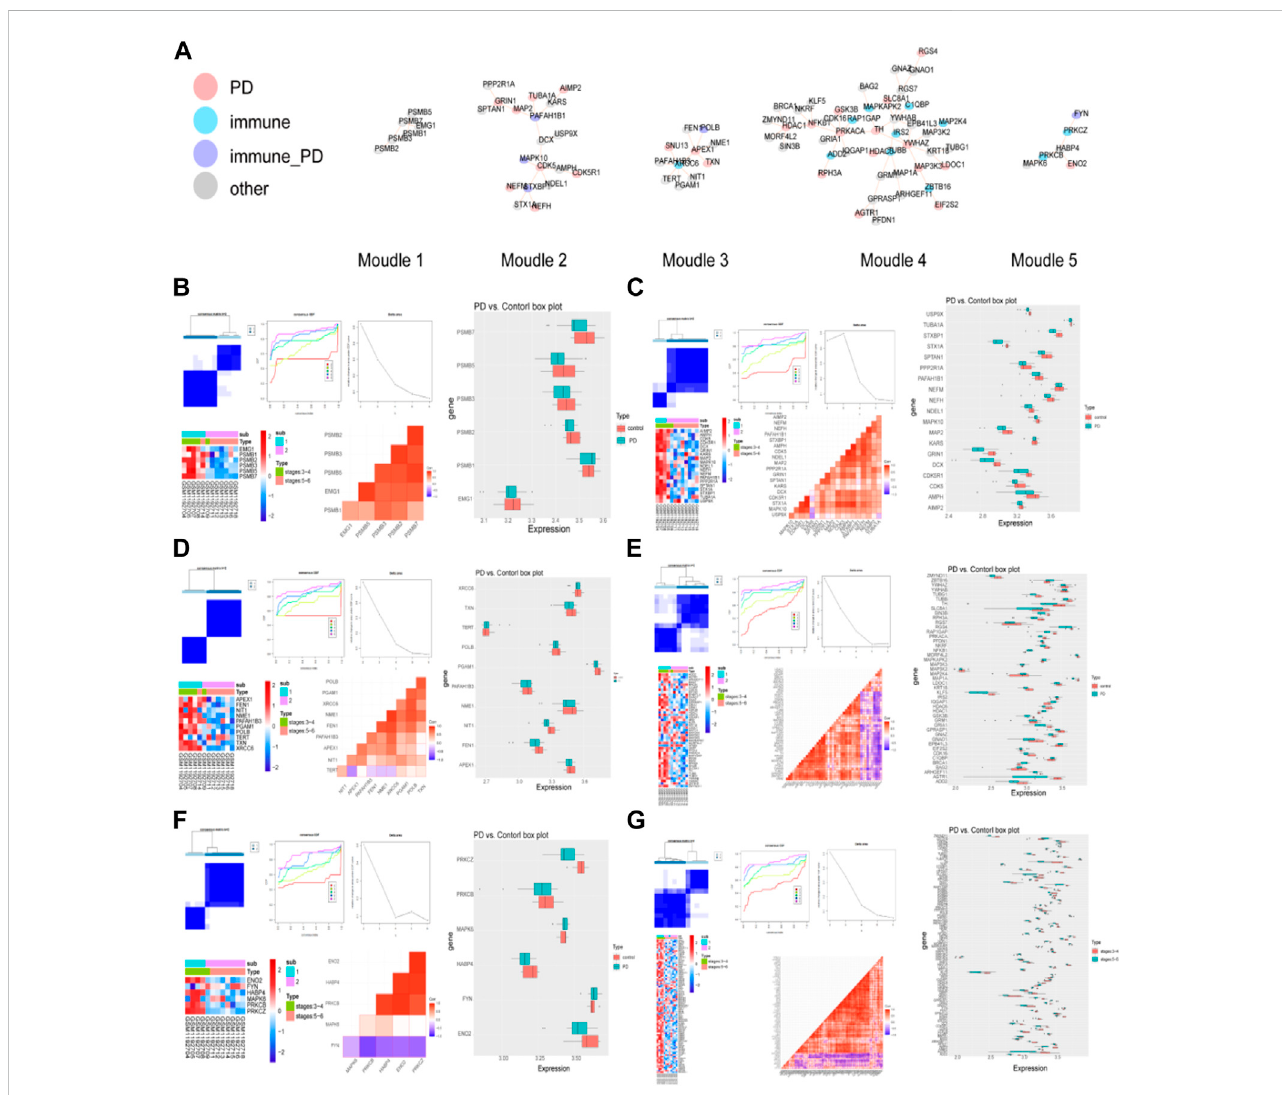
FIGURE 3 Detection of PD-related clusters and validation of their classi fi cation power. (A) Important clusters of modules were generated in the IPGDNC network. (B – G) The consensus cluster heatmap, cumulative distribution function (CDF) plot, delta area plot, gene expression heatmap, gene correlation heatmap, and gene expression box plot of modules including module 1 (B) , module 2 (C) , module 3 (D) , module 4 (E) , module 5 (F) , and the common genes (G)